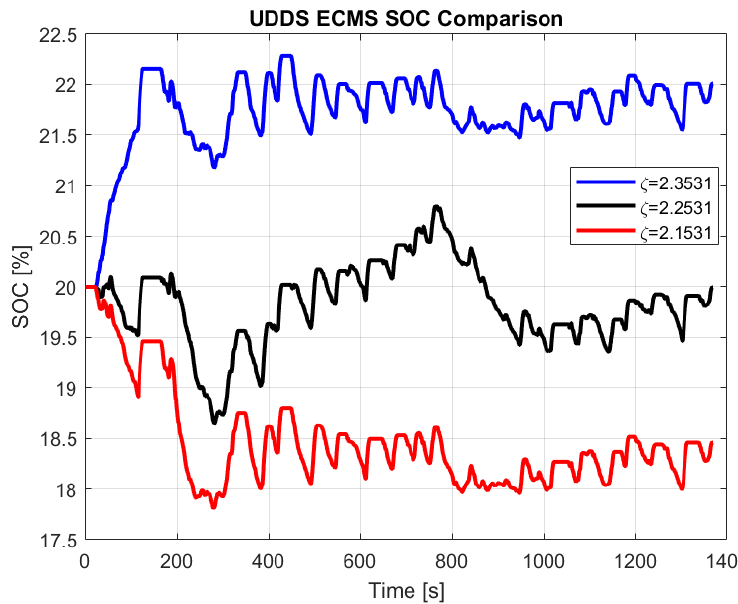
Figure 1. ECMS equivalence factor comparison for UDDS.